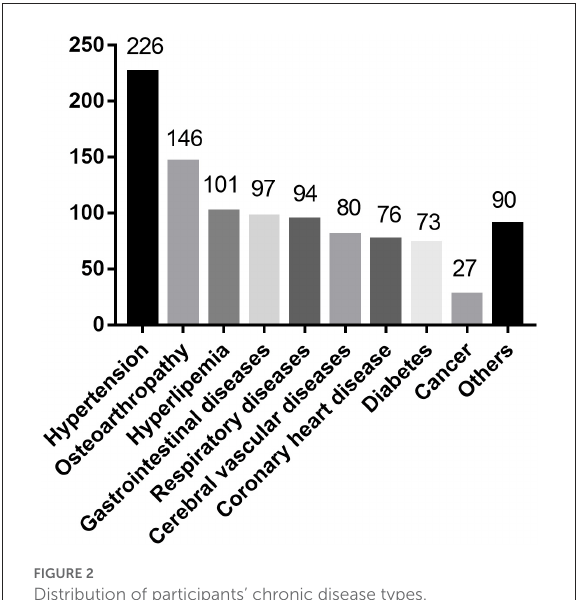
FIGURE3 Attributes on the better-worse plot.